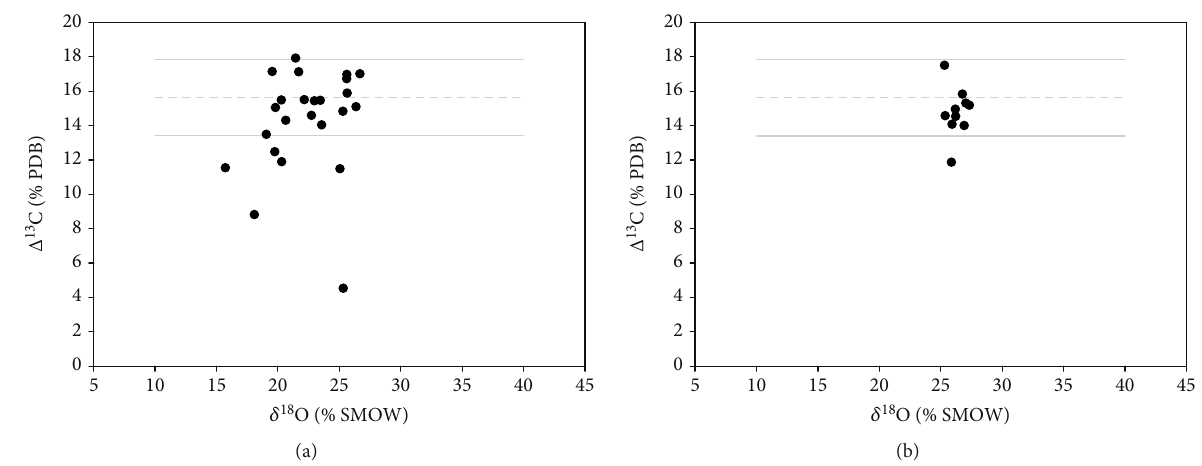
Figure 7: Plots of δ 18 O versus Δ 13 C. (a) This panel shows data from Hyland and Sheldon [28]. Using the Δ 13 C screening criteria outlined carb in the text, 18 of 24 carbonates formed in equilibrium. By removing the nonequilibrium carbonates from consideration, the range of δ 18 O values drops to ~ 6.5 ‰ from ~ 11 ‰ . Using the global δ 18 O lapse rate of Poage and Chamberlain [18], this would re fl ect a di ff erence of ~ 1.6km between the estimates of paleoelevation. (b) This panel shows the data from Gutierrez and Sheldon [27]. Using the Δ 13 C screening criteria outlined in the text, nine of ten carbonates formed in equilibrium. The dashed line in both panels represents the empirically observed mean Δ 13 C value of +15.62 ‰ ; the solid lines represent ± 2 σ (2.22 ‰